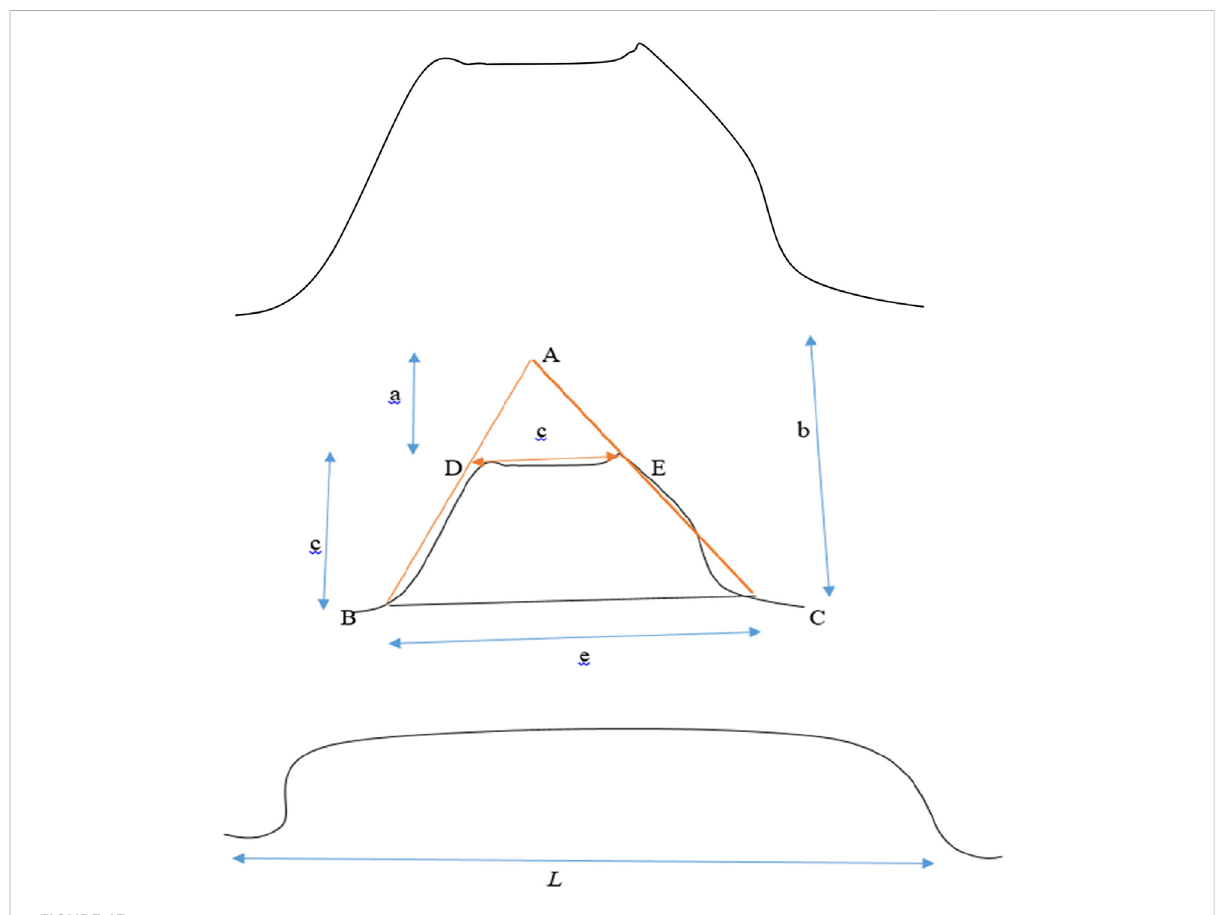
FIGURE 13 The shape of the stockpile inside (top) and front (down)